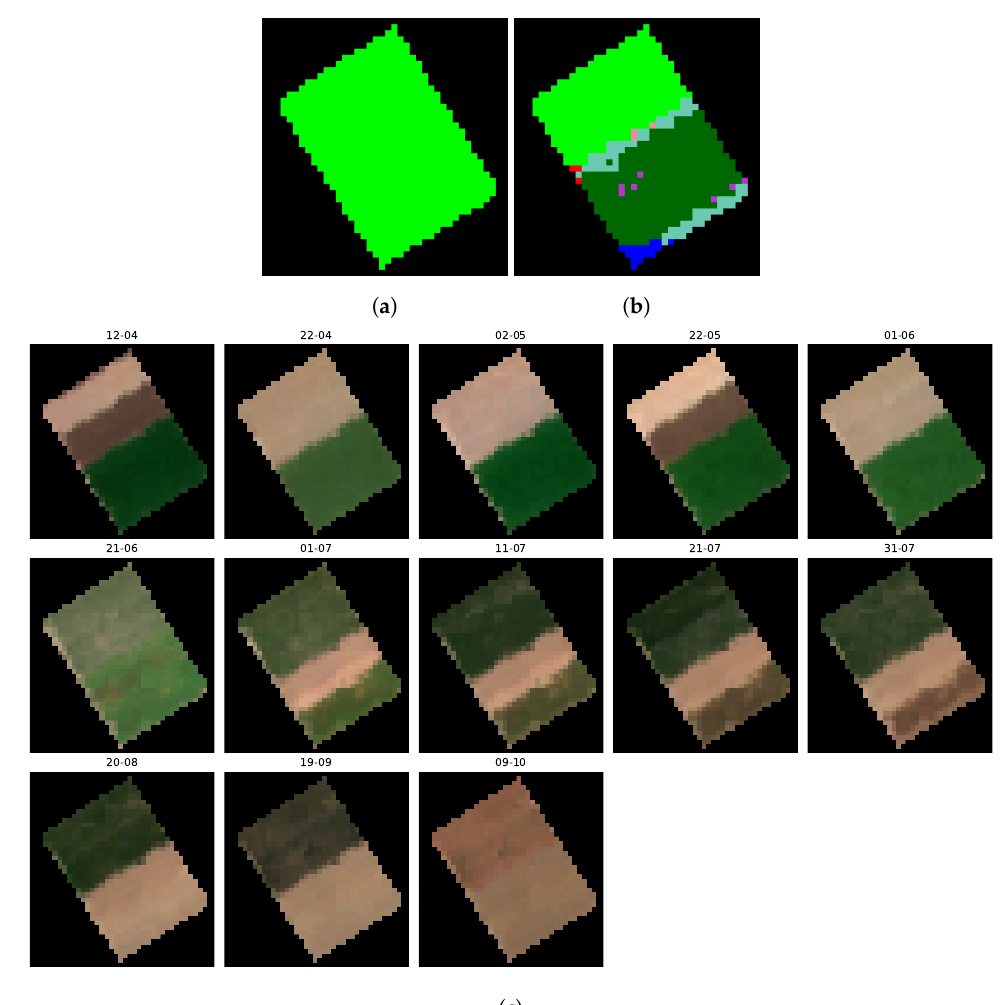
Figure 17. Comparison between the ground truth and candidate classes image of the first mis-split field, alongside multitemporal Sentinel-2 imagery of the parcel. ( a ) Ground truth class image of the mis-split field n°1. ( b ) Candidate classes image of the mis-split field n°1. ( c ) Sentinel-2 imagery of the first detected mis-split